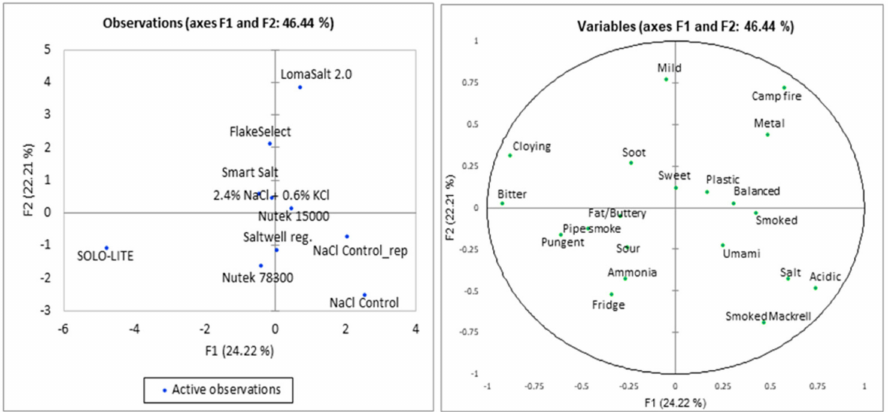
Figure 1. Sensory analysis by projective mapping. Observation plot and variables plot indicating terms mentioned six times or more, obtained from PM of 10 samples of CS salmon conducted by 10 trained assessors.